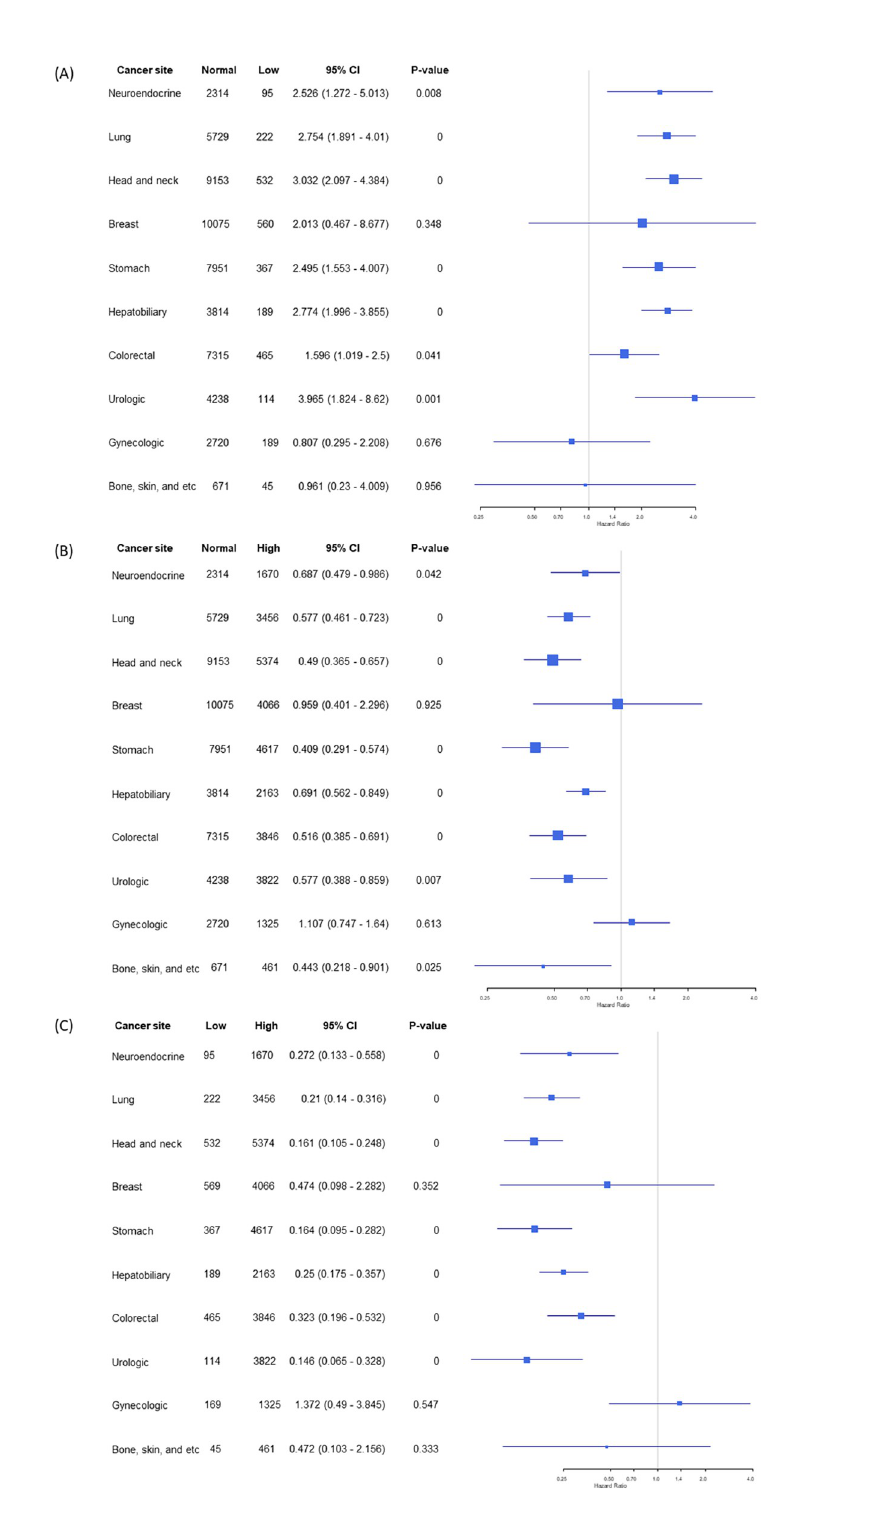
PLOS ONE | https://doi.org/10.1371/journal.pone.0270460 July 8,